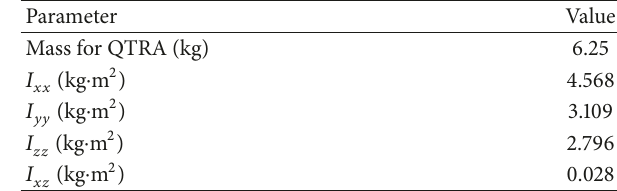
Table 1: Parameters for